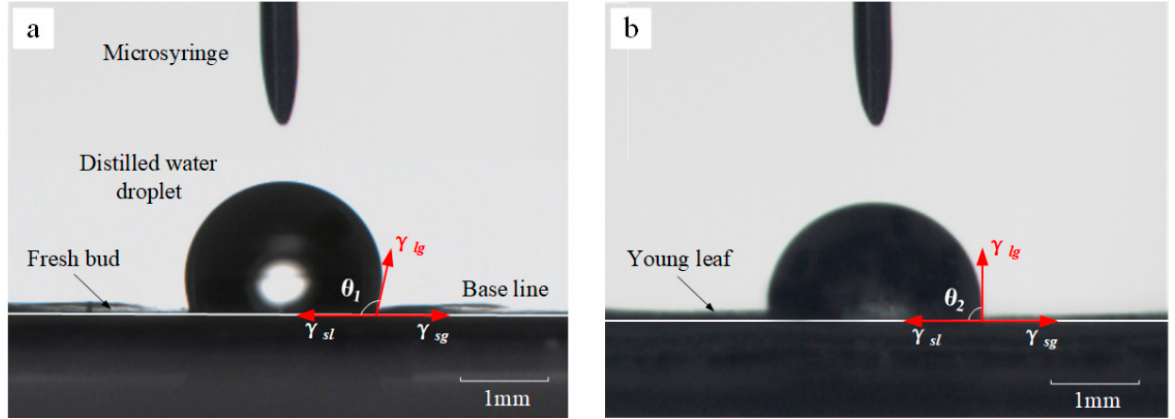
Figure 4. Deposition state of distilled water droplets on the surfaces of ( a ) fresh bud and ( b ) young leaf photographed by the CCD camera.